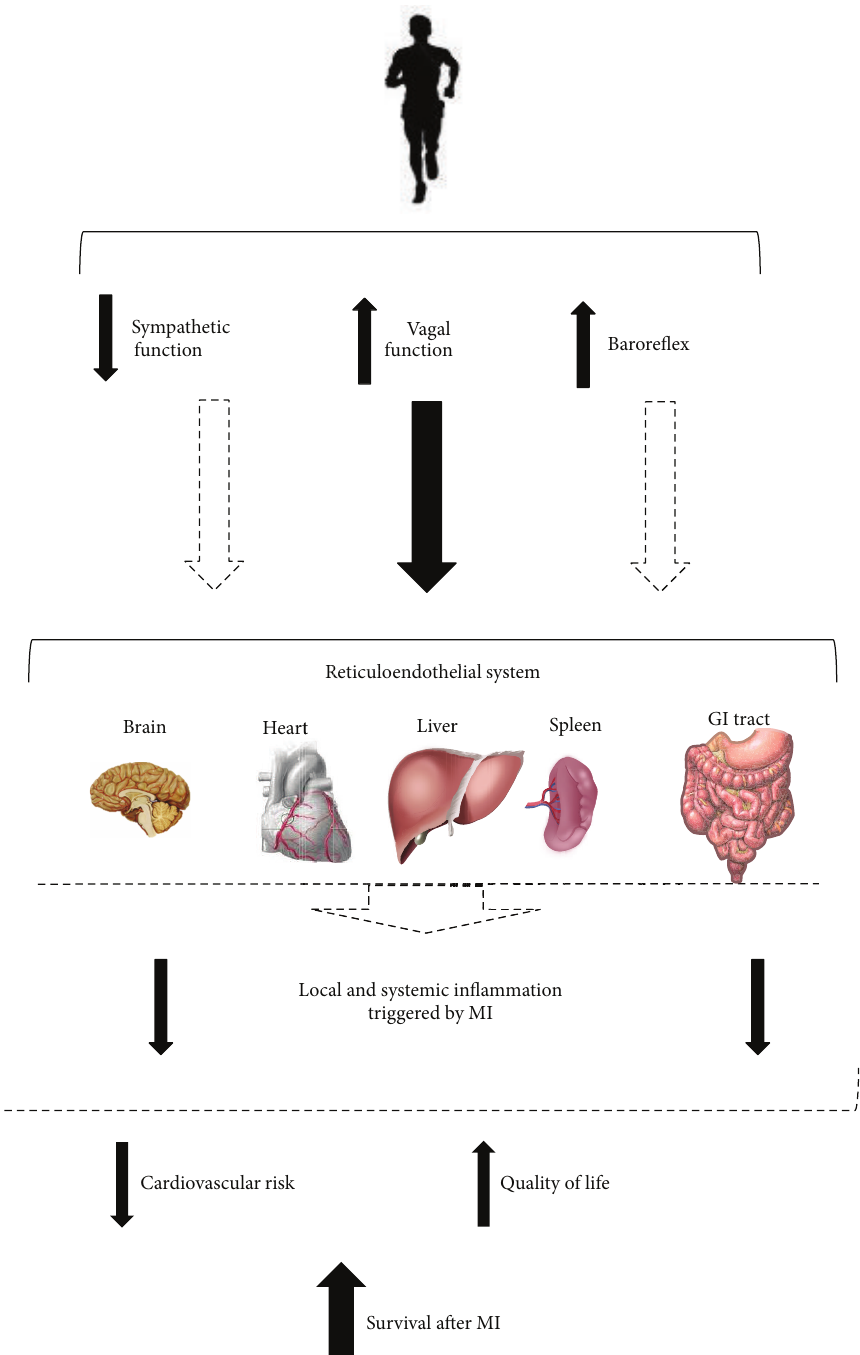
Figure 3: Possible mechanisms associated with inflammatory profile reduction in patients after myocardial infarction undergoing exercise